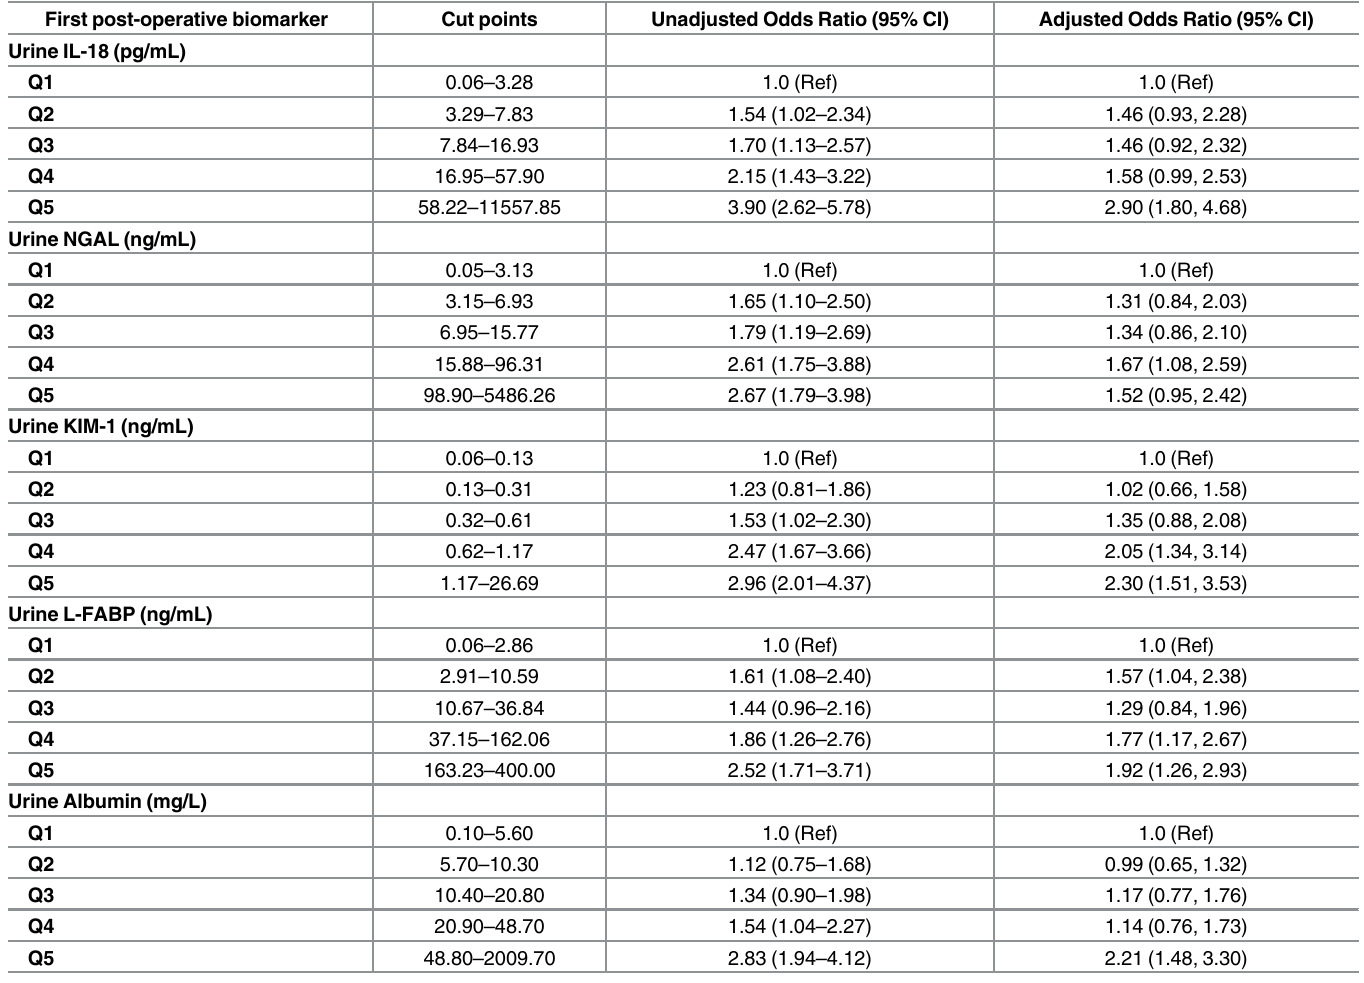
Table 3. Associations by Quintiles of Biomarkers for Increased Duration